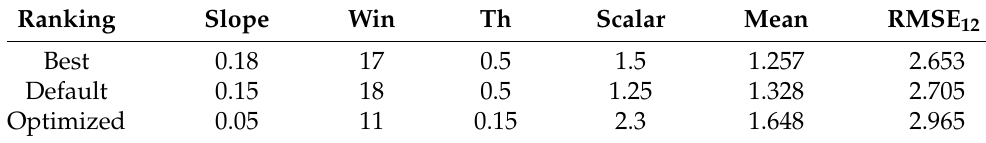
Table 6. RMSE error for different settings of the ODM ground segmentation. The optimized corre- sponds to the values recommended in [19]. Win stands for window and Th for threshold.